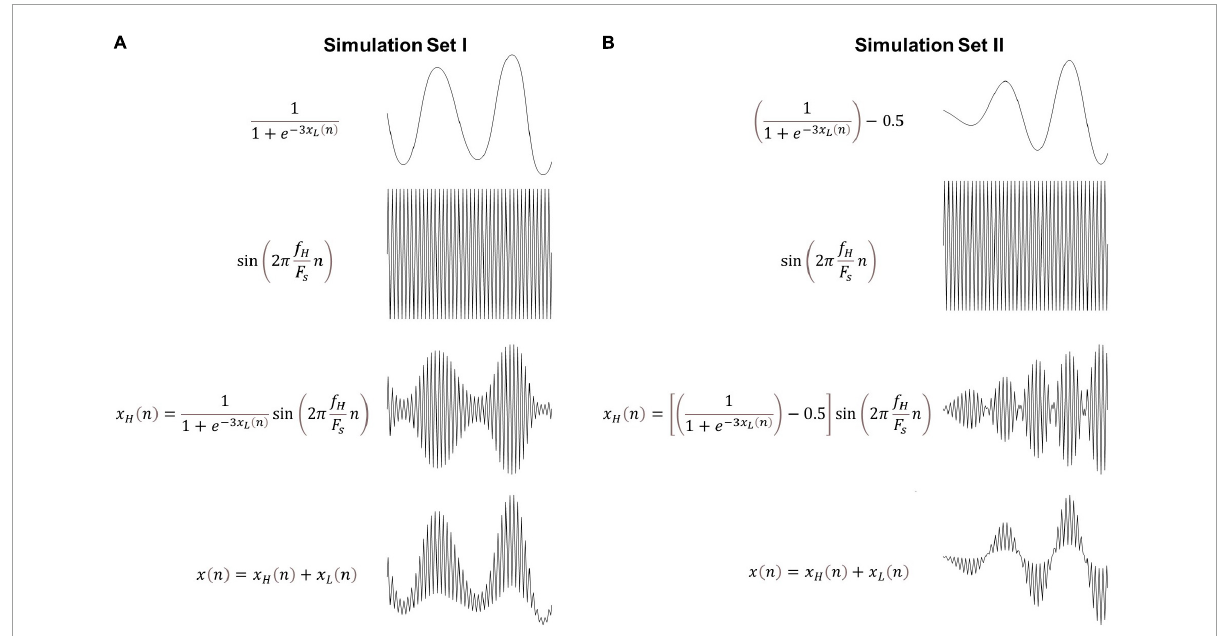
FIGURE2 Representative realizations of synthetic signals (Eq. 31) from (A) simulation set I (monophasic coupling) and (B) simulation set II (biphasic coupling). All depicted signals exhibit CFC between f L = 4 Hz and f H = 60 Hz. The sampling rate was set to F s = 240 Hz and the signal to noise ratio was 40